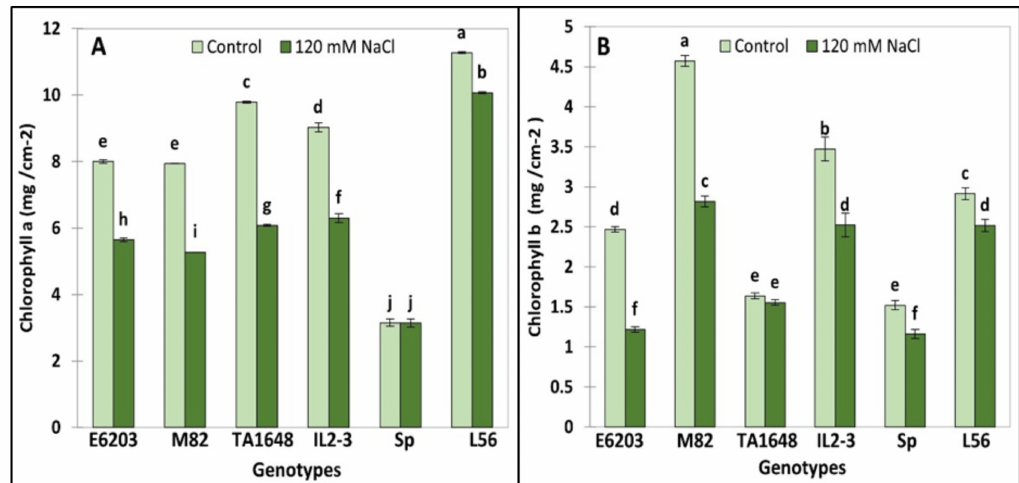
Figure 4. Chlorophyll concentration for two ILs (TA1648 and IL2-3), the cultivar parents (cv. E6203 and M82) and two salt-tolerant reference genotypes, “SP” (wild type) and “L56” (fixed variety) under control salt stress conditions (120 mM NaCl). ( A ) Chlorophyll a (Chl.a), ( B ) Chlorophyll b (Chl.b). Values are expressed as means ± SD of three plants per genotype. Different letters indicate statistically significant differences according to Duncan’s test ( p < 0.05).